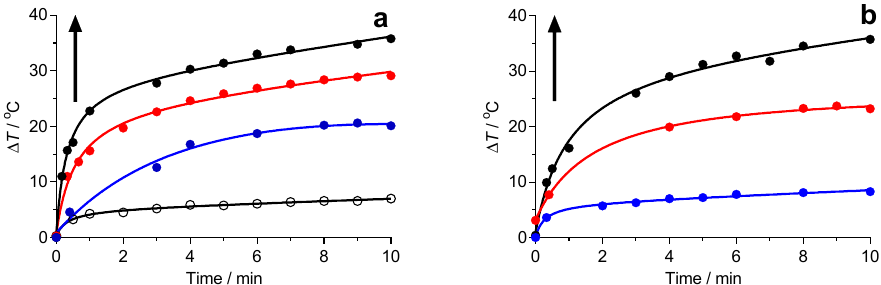
Figure 4. Plots of the temperature increase versus time during laser irradiation Concentration-dependent thermogenesis of IONs at ( a ) various concentrations at a power density of 8.7 W cm − 2 (black dots: 255 mg L − 1 ; red dots: 127.5 mg L − 1 ; blue dots: 51 mg L − 1 ; open dots: Water), and ( b ) at various laser power densities at an iron concentration of 51 mg L − 1 (black dots: 14 W cm − 2 ; red dots: 8.7 W cm − 2 ; blue dots: 3.5 W cm − 2 ).